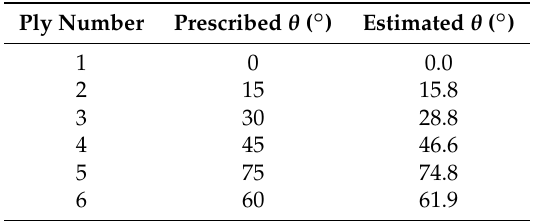
Figure 13. Microscope image of manufactured laminate with prescribed layer orientations: ( a ) ply layers identified and numbered; and ( b ) fit ellipses colored by determined θ ( ◦ ). Table 5. Manufactured plate fiber